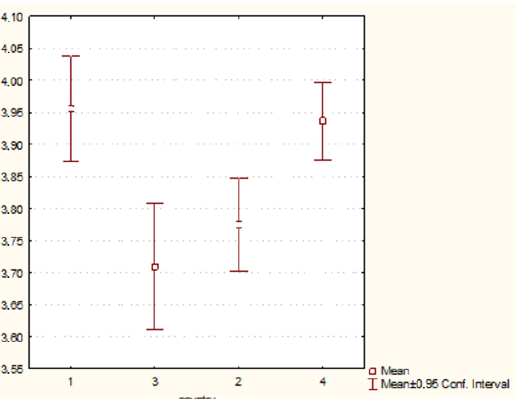
Figure 3. Psychosocial health behaviour and country of origin (H = 22.70252 p = 0.0000). Legend: 1 — Poland, 2 — Hungary, 3 — Greece, 4 — Turkey. No statistically significant differences were found in the scope of students not taking risky behaviours (H = 11.30513 p = 0.0102)—Figure 4.